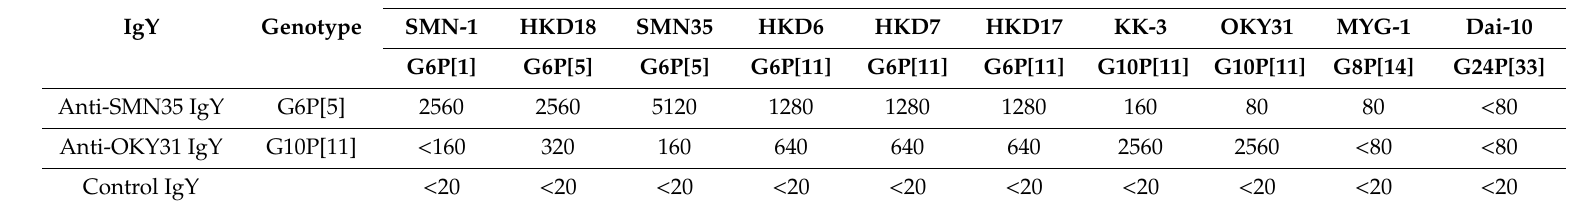
Table 2. Summary of neutralization antibody titers of two anti-bovine rotaviruses A (RVA) immunoglobulins Ys (IgYs) and one control IgY against ten bovine RVA